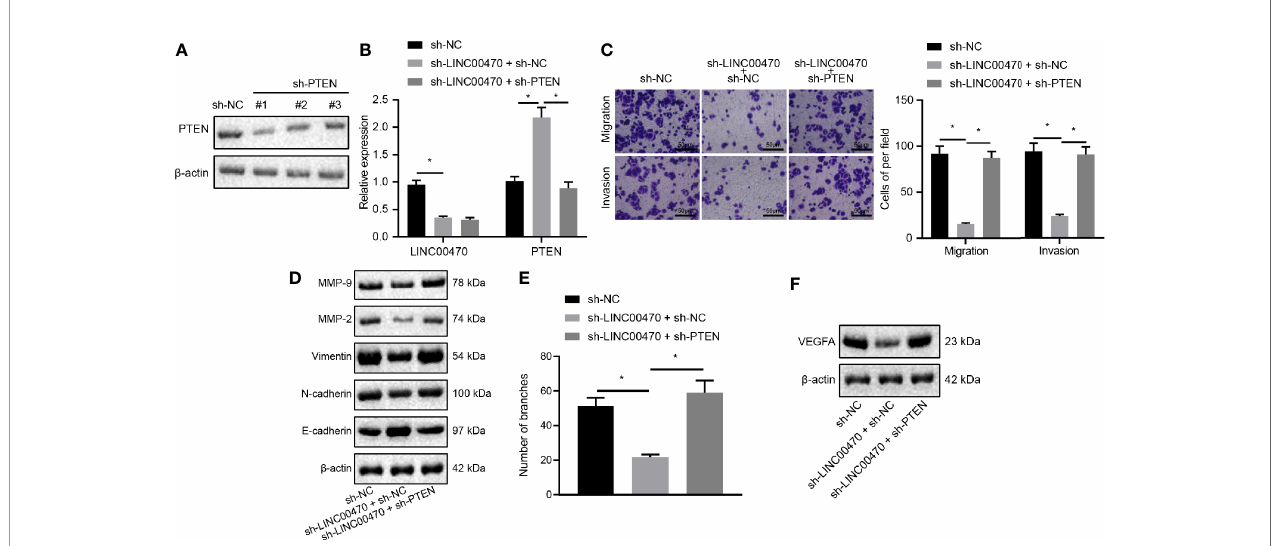
FIGURE 6 | Silencing of LINC00470 inhibited the invasive and migratory capacities of EC cells and angiogenesis through up-regulating PTEN. (A) Western blot analysis of the expression of PTEN in KLE cells after sh-PTEN-1, sh-PTEN-2, or sh-PTEN-3 treatment normalized to b -actin. (B) RT-qPCR determination of LINC00470 and PTEN expression after sh-LINC00470 or sh-PTEN treatment. (C) Changes in cell migration and invasion ability after sh-LINC00470 or sh-PTEN treatment assessed by Transwell (scale bar = 50 m m). (D) Western blot analysis of the Vimentin, E-cadherin, N-cadherin, MMP-9, and MMP-2 expression after sh- LINC00470 or sh-PTEN treatment normalized to b -actin. (E) Cell tube formation ability assessed by tube formation experiment. (F) Western blot analysis of the expression of VEGFA after sh-LINC00470 or sh-PTEN treatment. The experimental data were expressed as mean ± standard deviation, and the comparison between two groups were conducted using independent sample t -test. One-way ANOVA and Tukey ’ s post hoc test were used for data comparison among multiple groups, * p <